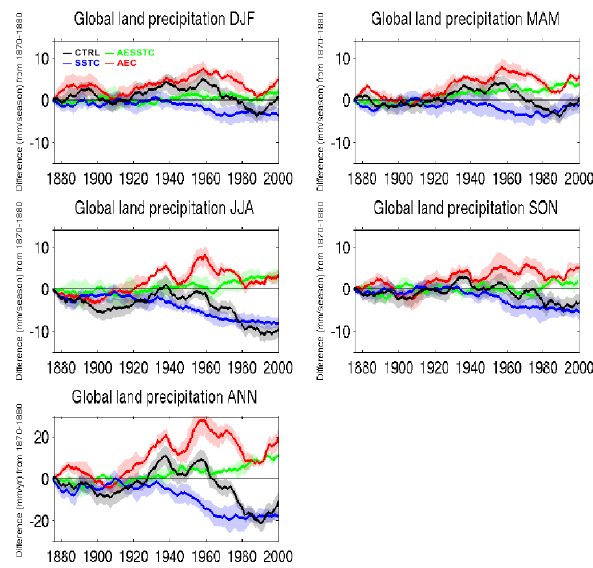
Fig. 7. Simulated annual and seasonal global land precipitation Figure 7. Simulated annual and seasonal global land precipitation anomalies (mm/season and anomalies (mmseason − 1 and mmyr − 1 , respectively), relative to mm/year, respectively), relative to the 1870-1880 mean, shown as 11-years running means. the 1870–1880 mean, shown as 11yr running means. Shaded areas Shaded areas correspond to the +/- 1 sigma spread of each ensemble. correspond to the ± 1 sigma spread of each